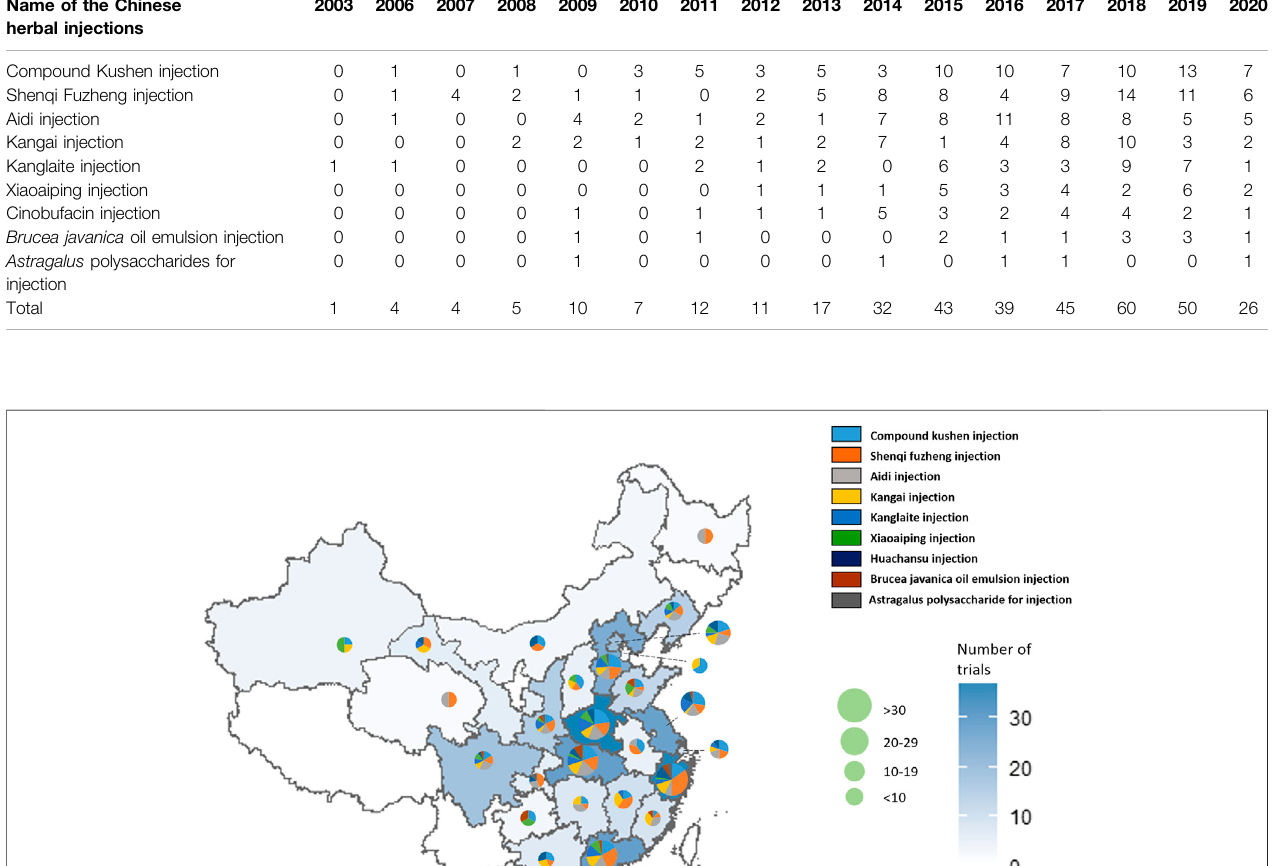
Frontiers in Pharmacology |